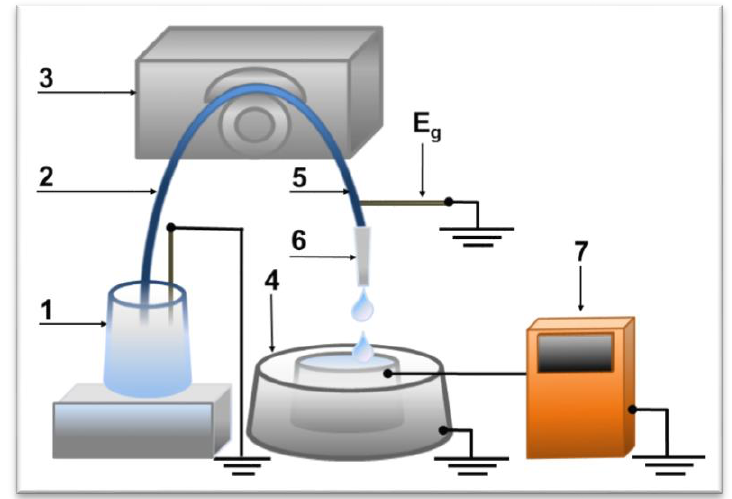
Figure 1. Block scheme of the charge measuring device in the solution, permanently delivered to the AFM-fishing system measuring cell: 1—a grounded container with the flowing solution; 2—silicone tubing (the input part); 3—peristaltic pump; 4—measuring cell linked to an electrometer; 5—silicone